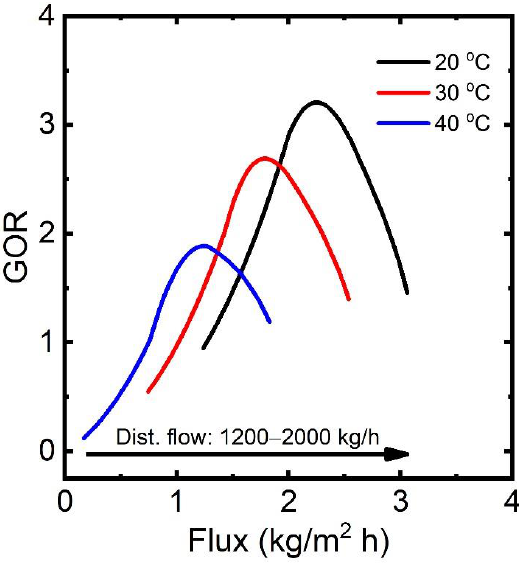
Figure 6. GOR–flux performance for permeate condition in DCMD with varying distillate flow rate of 1200–2000 kg/h and temperature of 20–40 ◦ C. Note that GOR and flux are calculated from the DCMD-based desalination process at each condition.